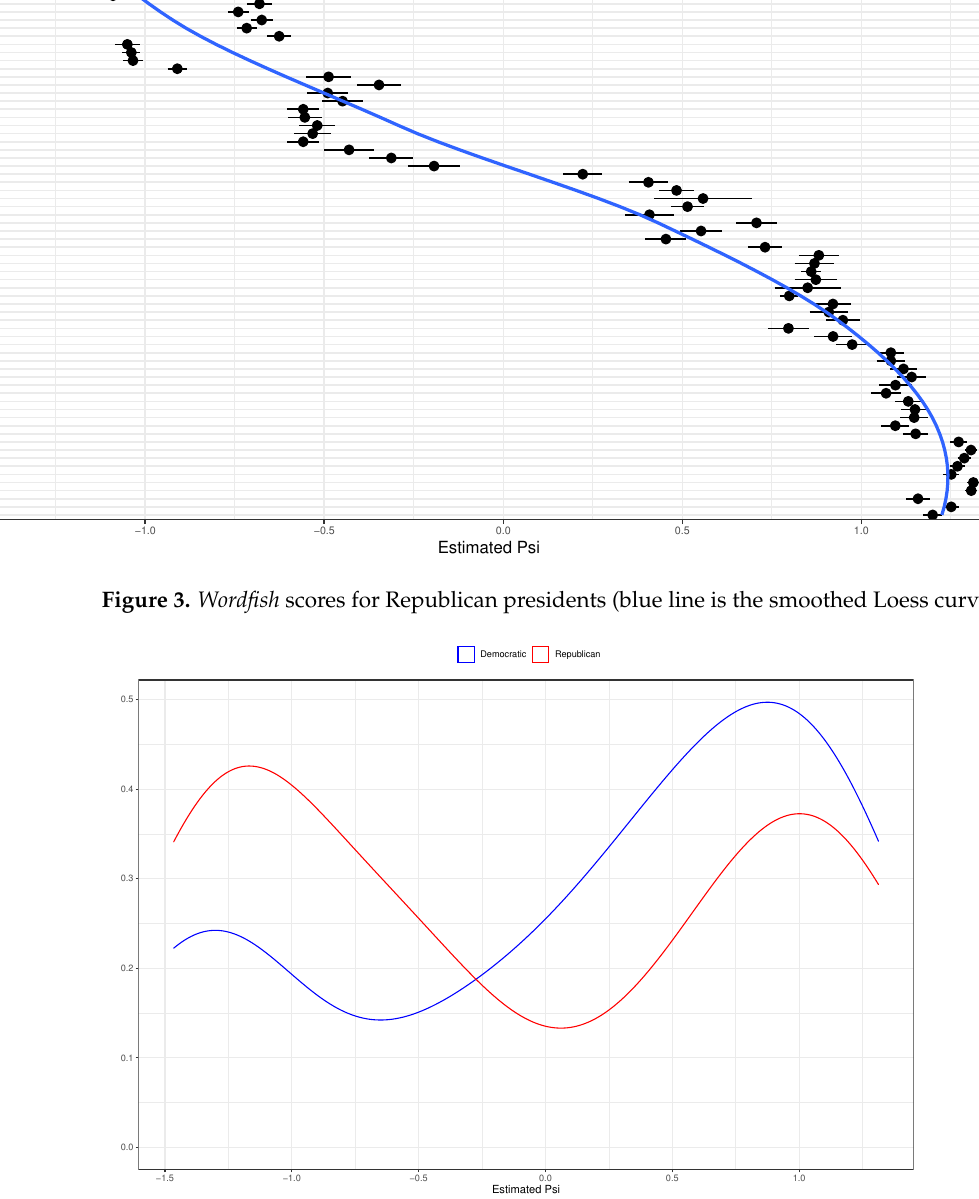
Figure 4. Density plots of Wordfish scores by